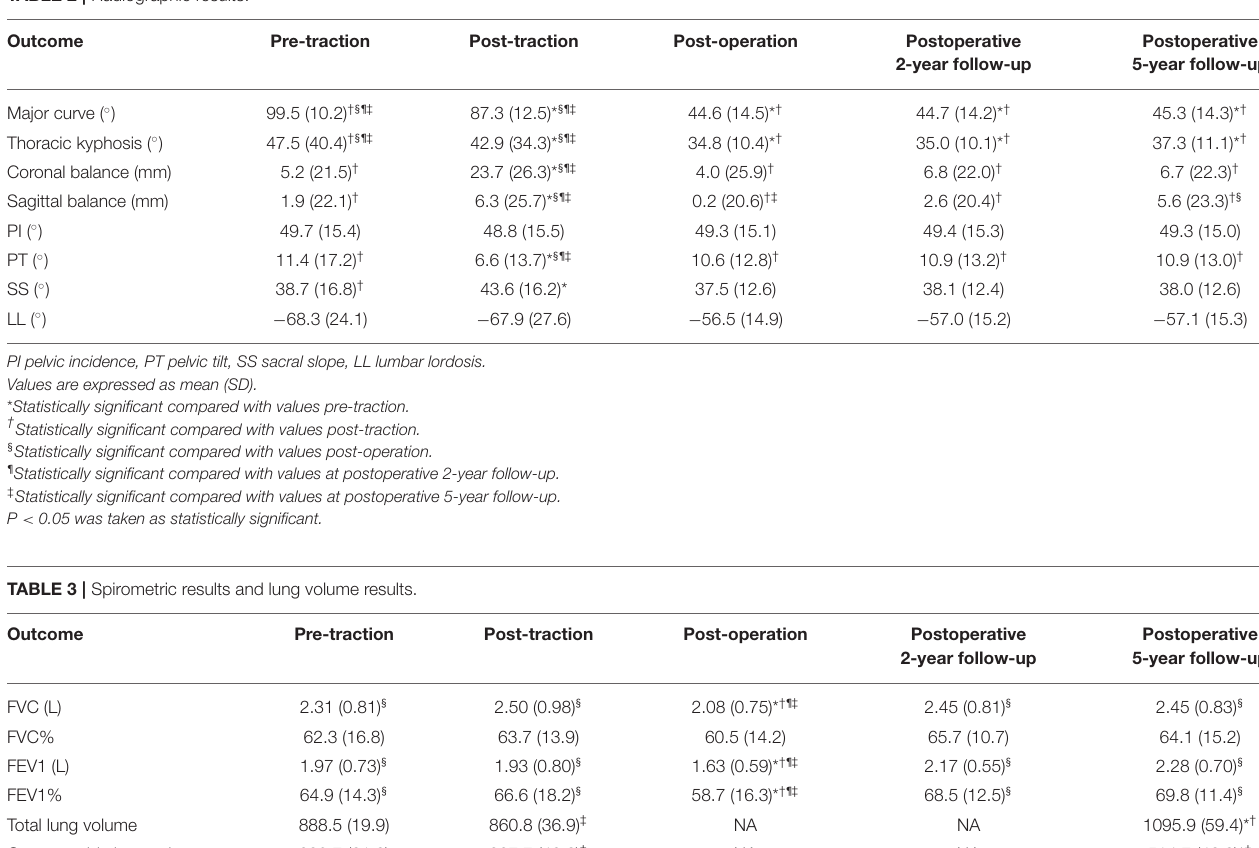
TABLE 2 | Radiographic results.